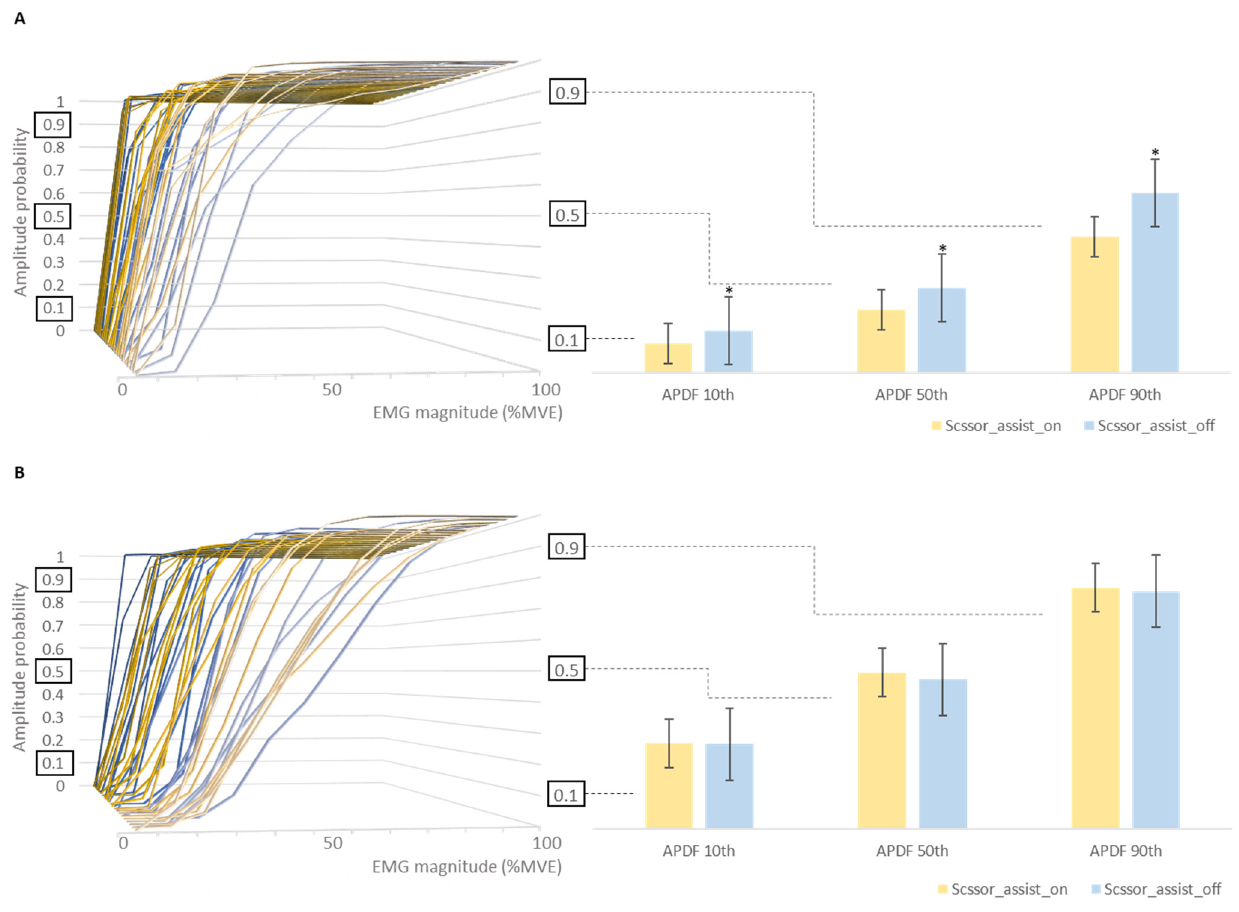
Figure 3. Comparison of muscle activity levels with and without power assistance, by plotting the probability of appearance of % maximal voluntary electrical activity (MVE) in the adductor pollicis muscle. ( A ) Amplitude probability distribution function (APDF) analysis plots of the adductor pollicis muscle (ADP) are shown, and muscle activity compared. ( B ) Amplitude probability distribution function analysis plots of the extensor carpi radialis (ECR) muscle are shown, and muscle activity compared. * p < 0.05. The polygonal line (on the left side of the A and B panels) represents the APDF value calculated from the surface electromyogram (sEMG) during scissors operation, and when the maximum pinch force was generated (y-axis, amplitude probability; x-axis, %MVE). Amplitude probability distribution function analysis shows the mean of the 10th percentile, 50th percentile, and 90th percentile of %MVE. The yellow line indicates with assistance; blue line, without assistance; and the values of P0.9 were used to rearrange and display each in ascending order. The bar graphs (to the right of A , B ) compare muscle activity at each percentile by assistance condition. Error bars show the mean standard error.